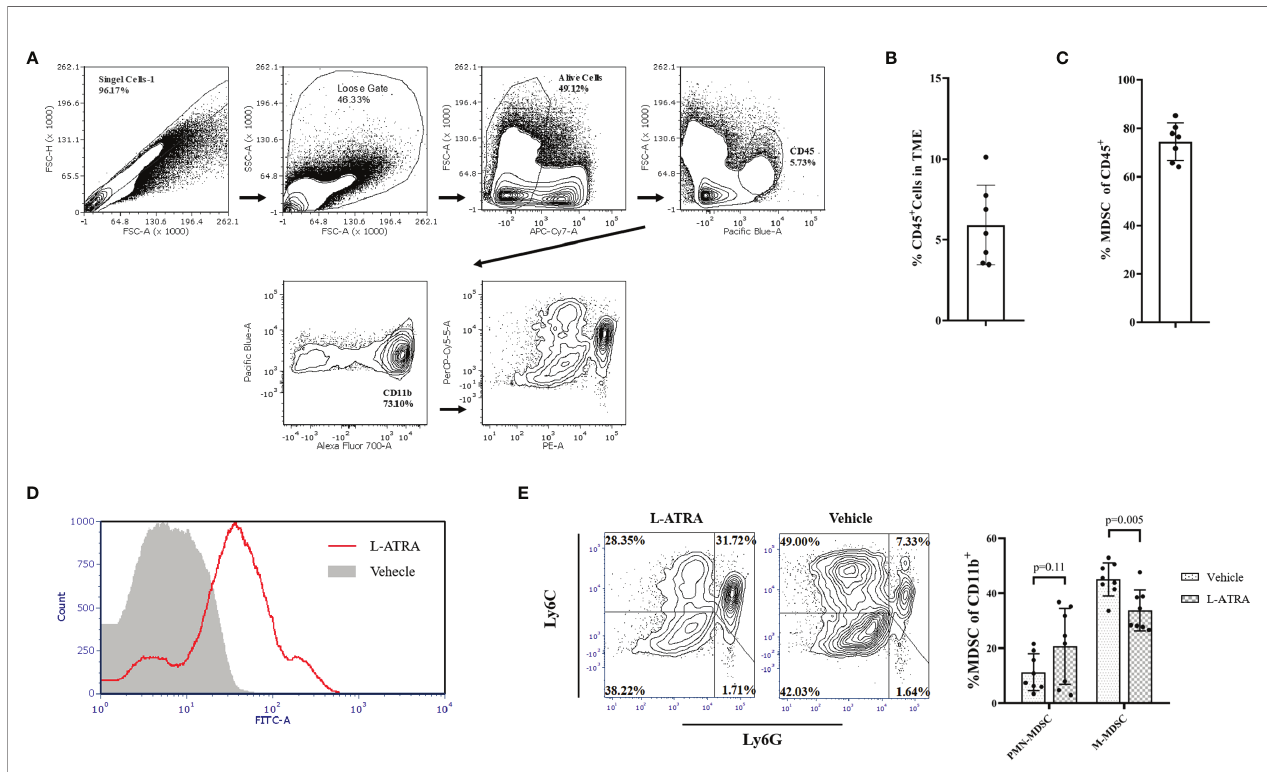
FIGURE 6 | The effects of L-ATRA on modulating the tumor microenvironment. (A) Analysis scheme of the tumor in fi ltration myeloid cells; (B) The percent of CD45 + lymphocyte cells in tumor tissues; (C) The proportion of CD11b + myeloid cellsin the tumor in fi ltration lymphocyte; (D) Binding of fl uorescent labeled L-ATRA to CD11b + tumor in fi ltrating myeloid cells in vitro ; (E) FACS analysis of the tumor in fi ltrating myeloid cell after treatment with